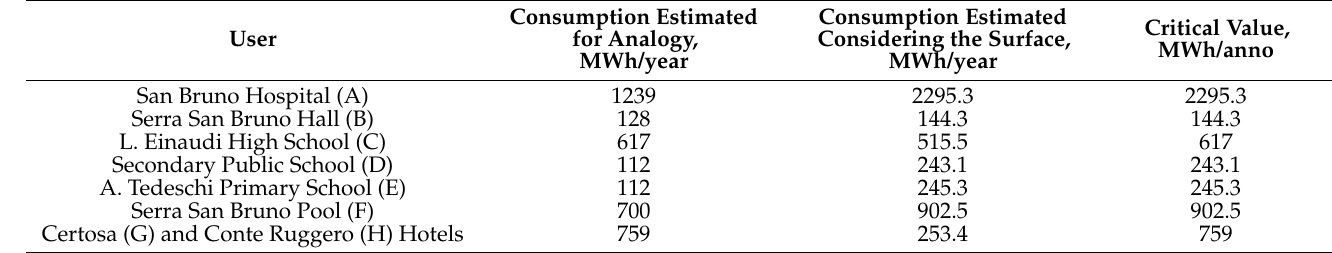
Table 5. Consumption due to heating calculated for analogy and considering the surface of the